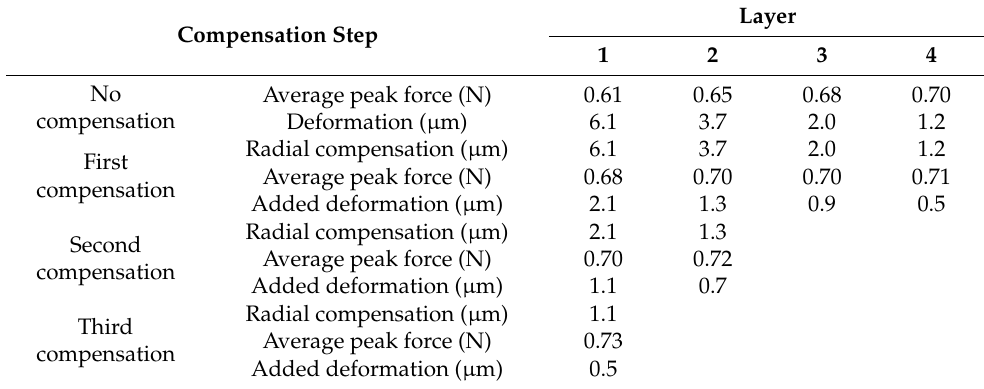
Table 5. The simulation results for the thin wall of 100 µ m thickness.